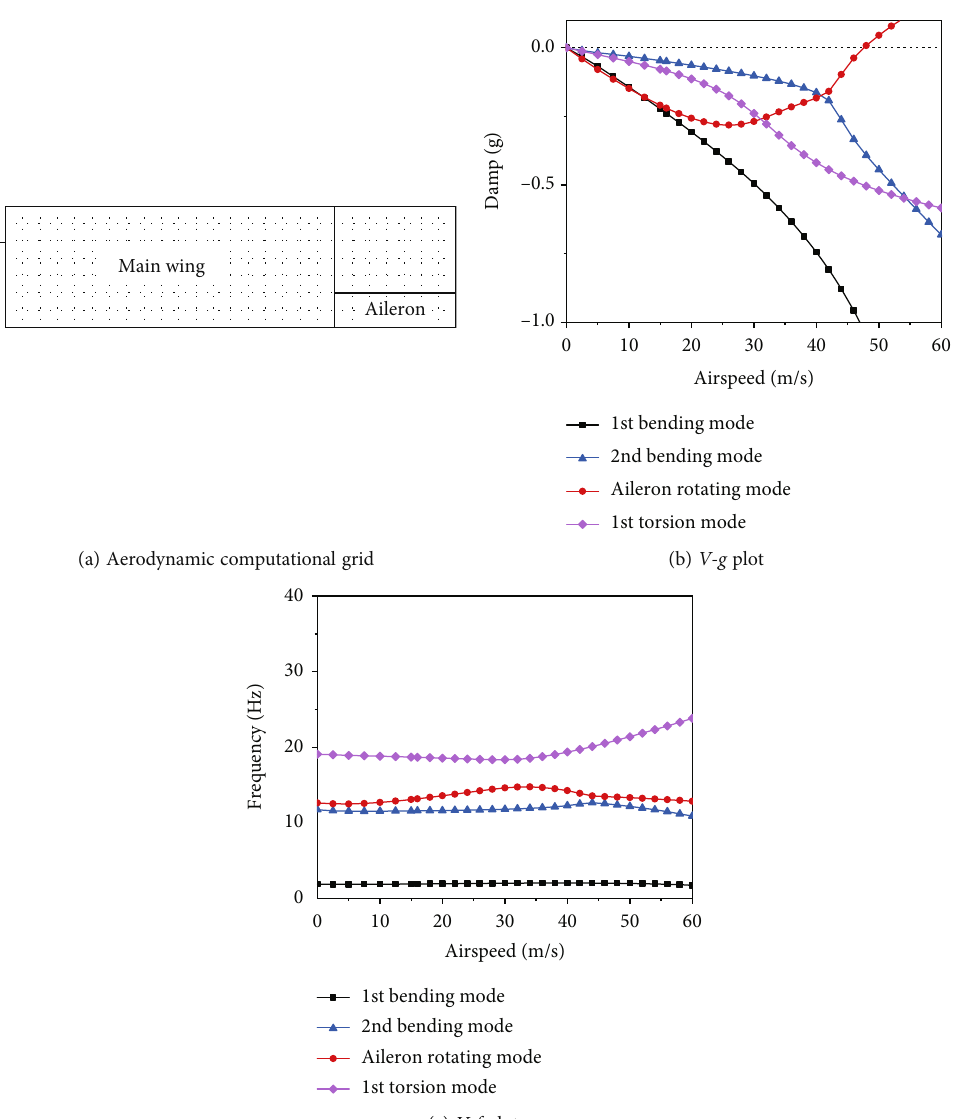
Figure 17: The results of linear fl utter